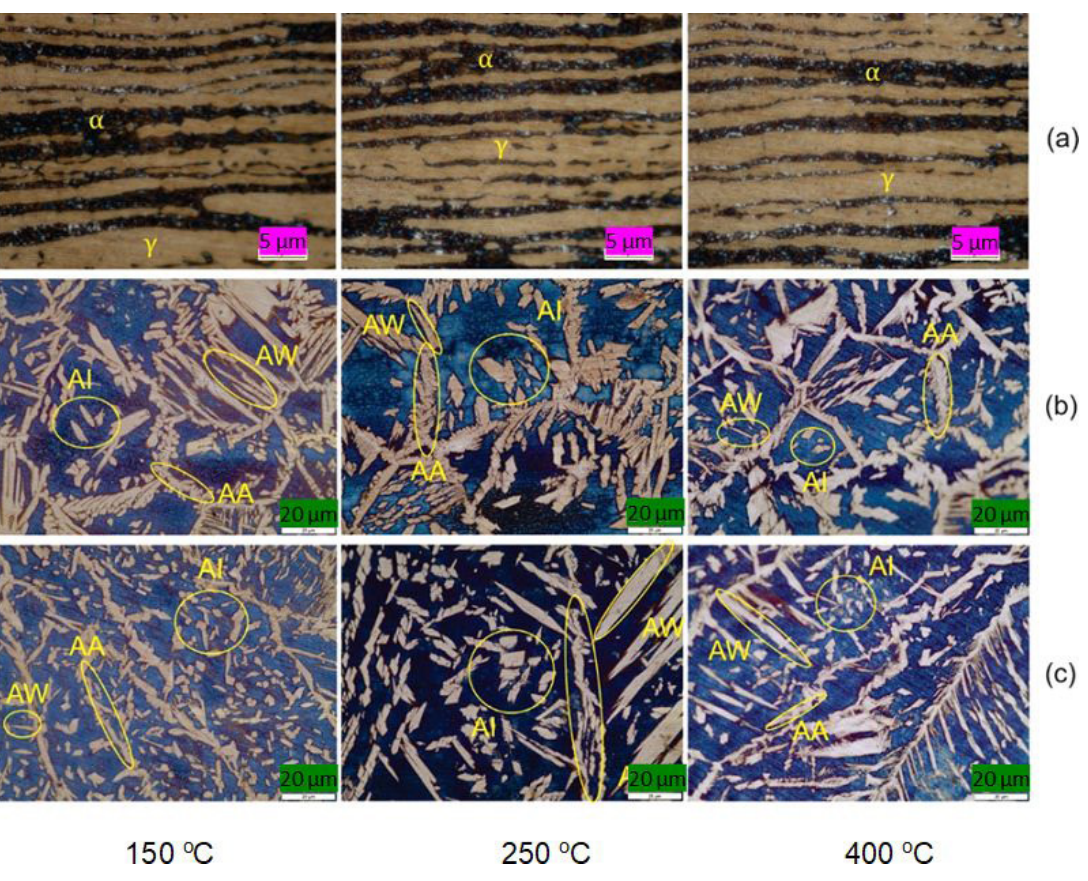
Figure 4. Morphology of the microstructures observed in the regions: (a) base metal BM, (b) heat affected zone HAZ, and (c) fusion zone FZ, with inter-passes temperatures of 150 °C, 250 °C, and 400°C, respectively. (Caption: AW - Widmanstätten austenite; AA - allotriomorphic austenite; AI - intragranular